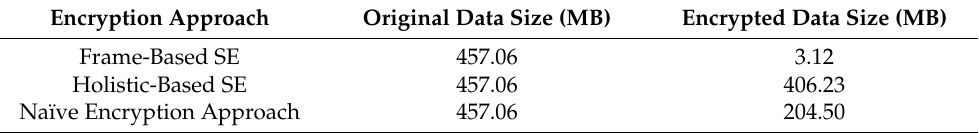
Table 7. The original and encrypted data